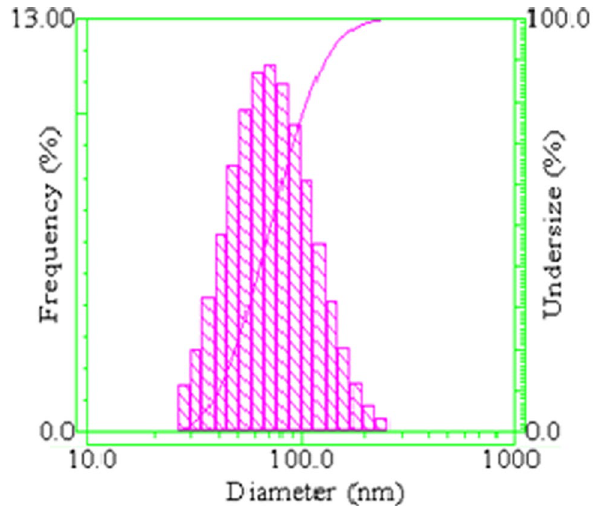
Fig. 6 Particle size analyzer image of core–shell nanocomposite